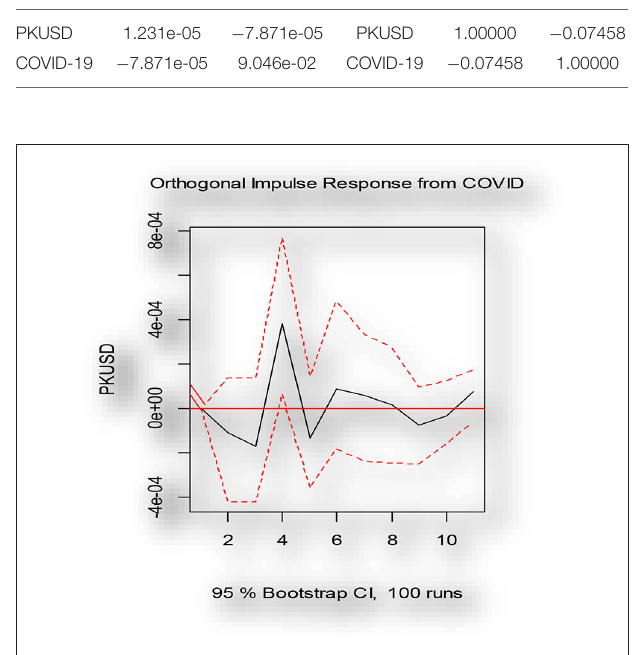
FIGURE 6 | Impulse response function.